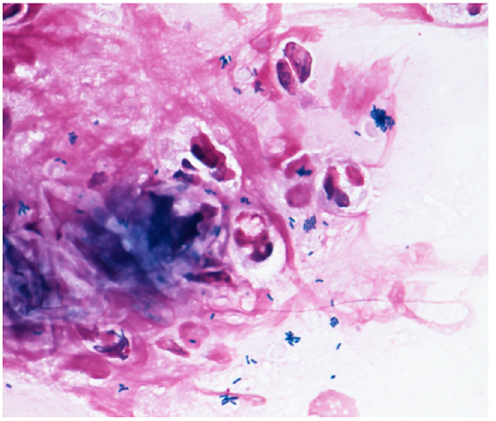
Figure 2. Gram staining. The Gram stain procedure revealed that gram-positive rod- were phagocytosed by polymorphonuclear shaped bacteria were phagocytosed by polymorphonuclear leucocyte.